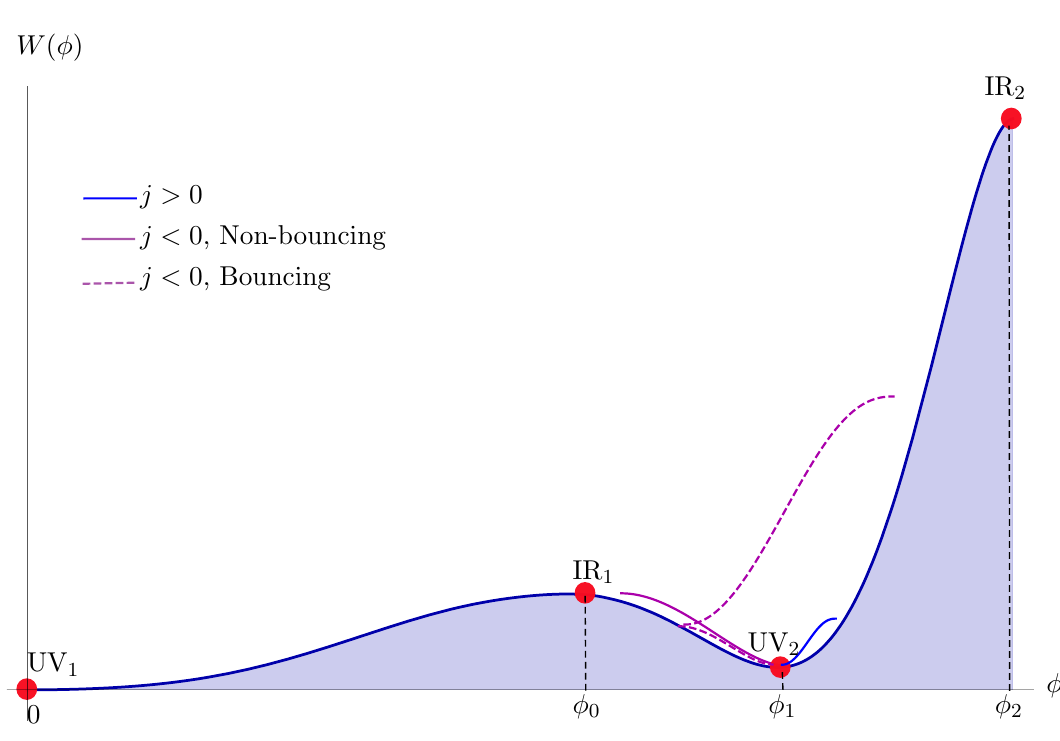
Figure 11 . Finite temperature solutions arising from the potential (3.1) and connecting to UV 2 . shown in (cid:12)gure 6. As the temperature is increased, the scalar (cid:12)eld endpoint